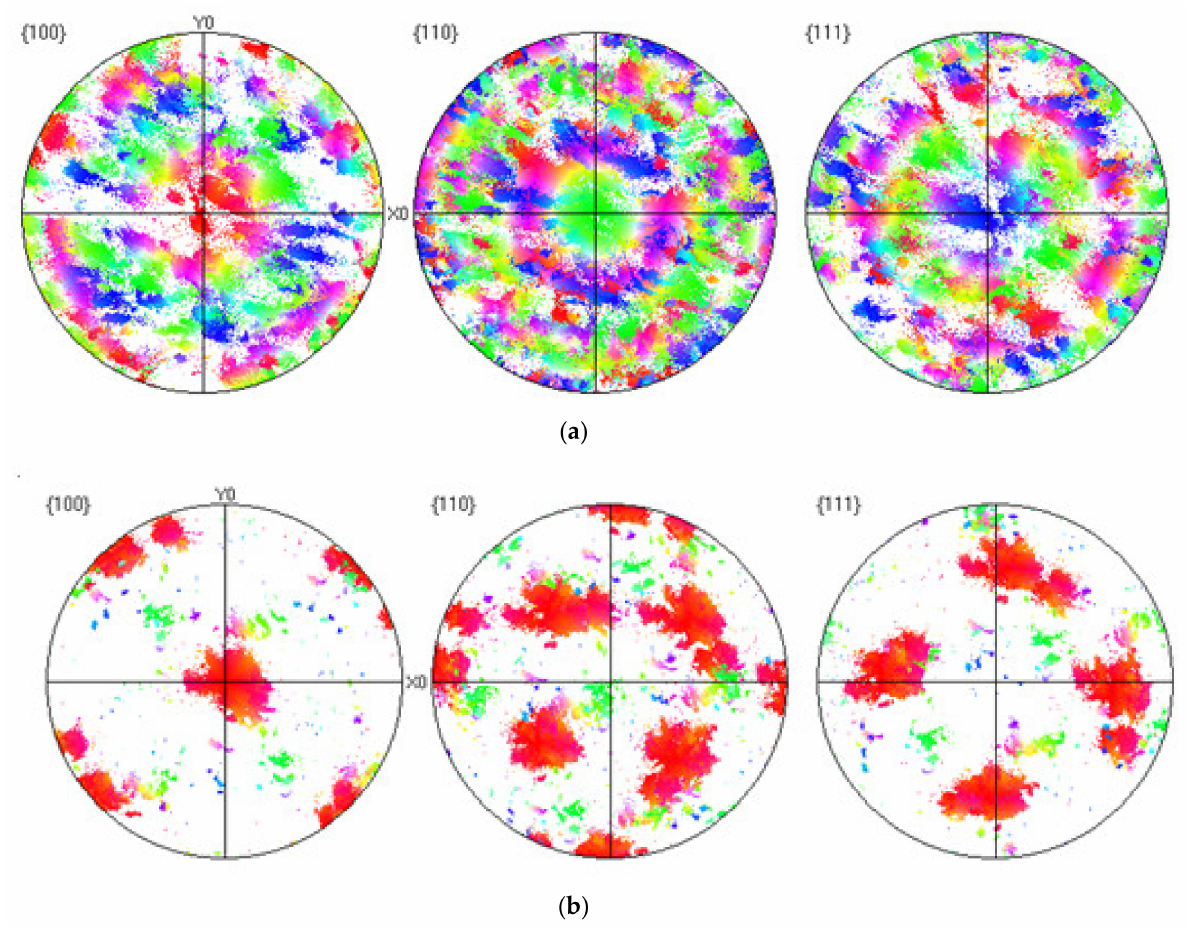
Figure 6. ( a ) Pole figures depicting the tungsten textures measured in the planes for sample 1. ( b ) Pole figures depicting the tungsten textures measured in the planes for sample